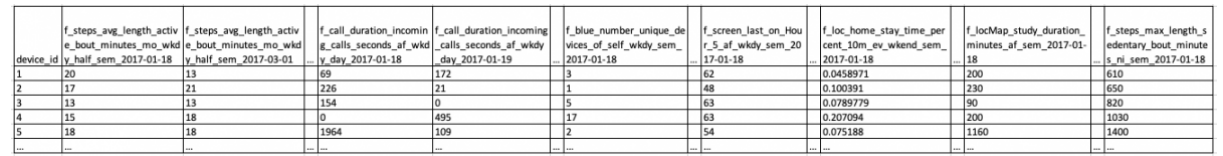
Handling Missing